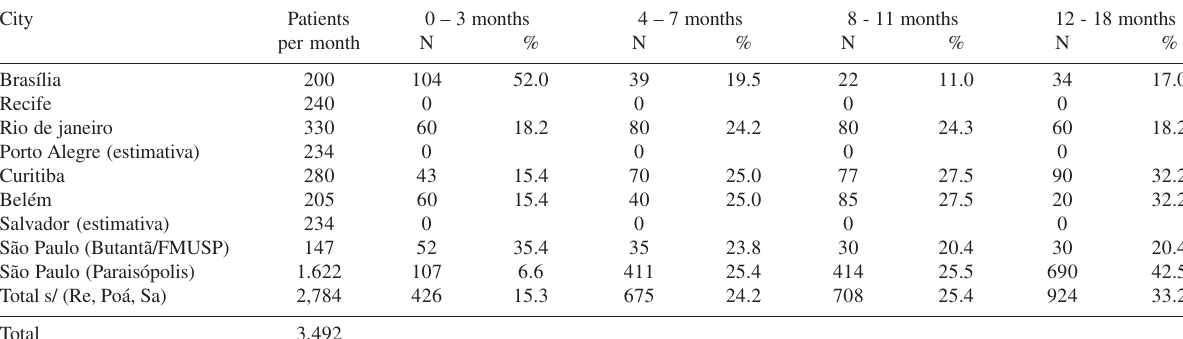
Table 1 - Number of appointments per month distributed per health service and age group. City